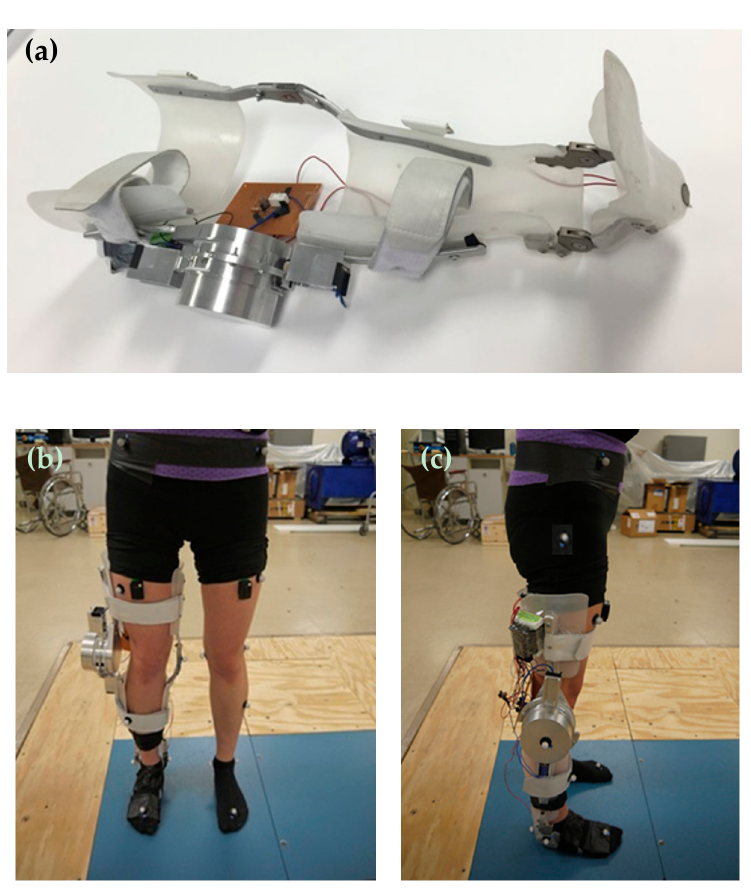
Figure 15. ( a ) The proposed KAFO Prototype with the Knee Module, the Control System, the Foot Switch, and the 12VDC Battery; ( b ) the frontal and ( c ) the lateral views of the subject wearing the dynamic KAFO for motion analysis test